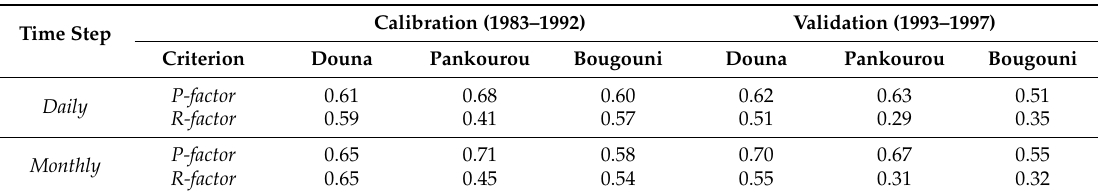
Table 6. Predictive uncertainty indices of the SWAT model for the Bani catchment at Douna, Pankourou, and Bougouni discharge gauging stations.